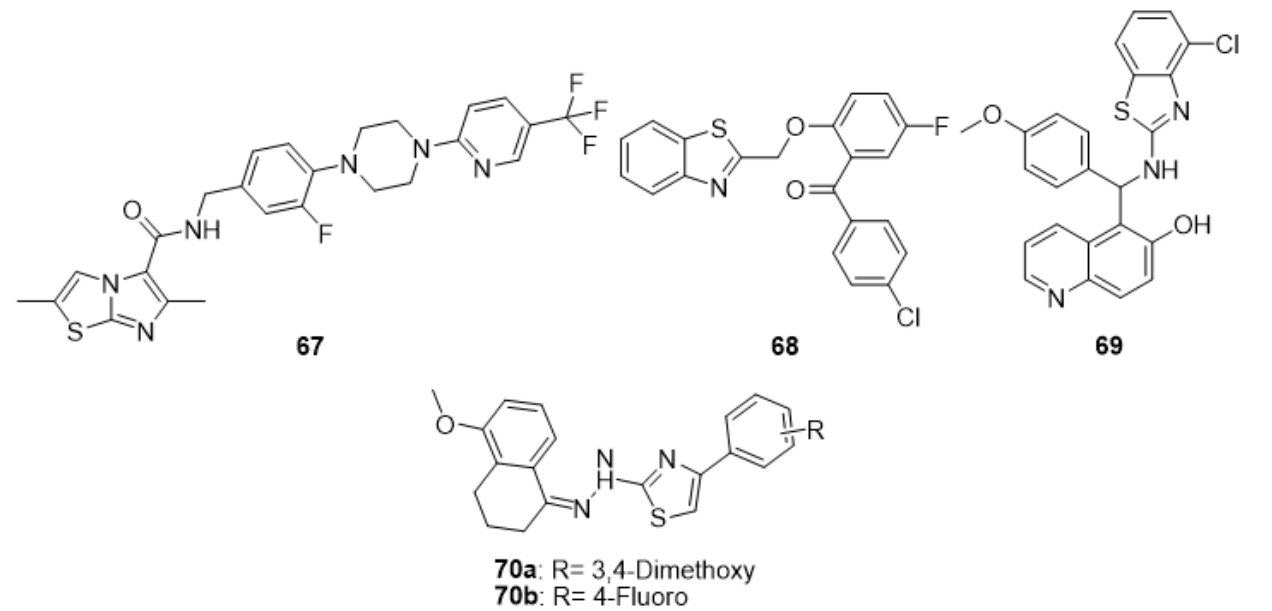
Figure 6. Recently designed and synthesized thiazoles as potential anti-tubercular agents.